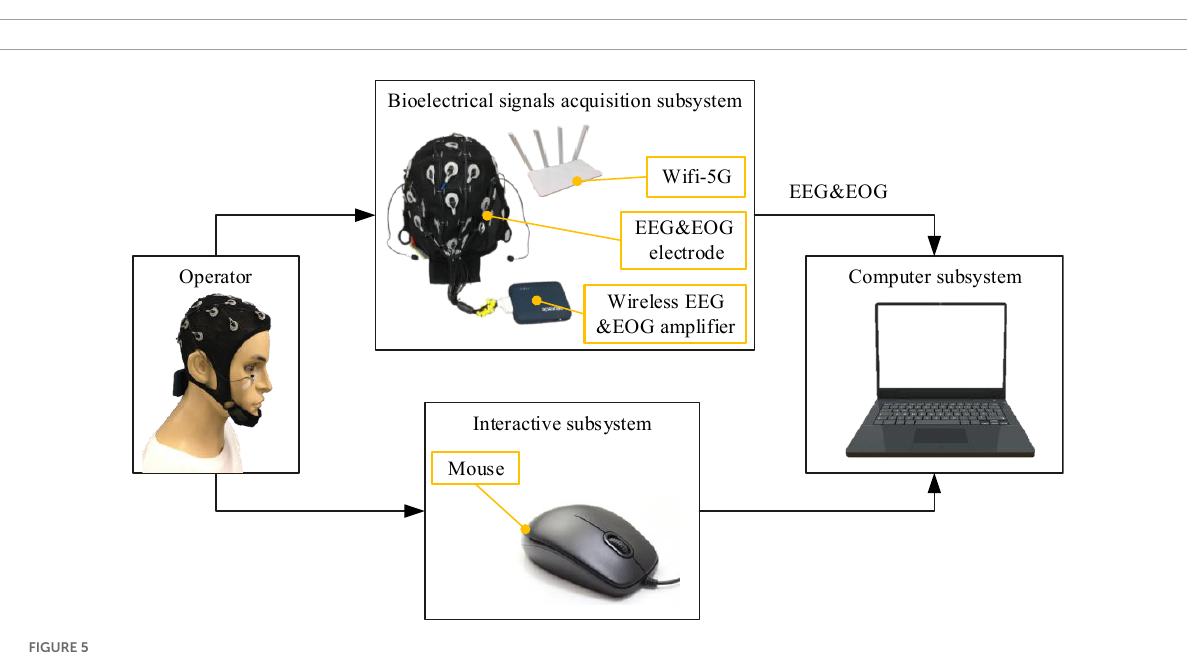
target. When the rectangular frame of the sight fully enclosed the target’s ring and was locked for a while, the target positioning mission was considered successful. The task completion time was recorded to evaluate the operational quality (the calculation formula is as shown in section “Personalized speed adaptation model trainer”) of the target positioning task. The bullseye moved randomly to the next position after each round. The control instructions of the robot were controlled by the operator